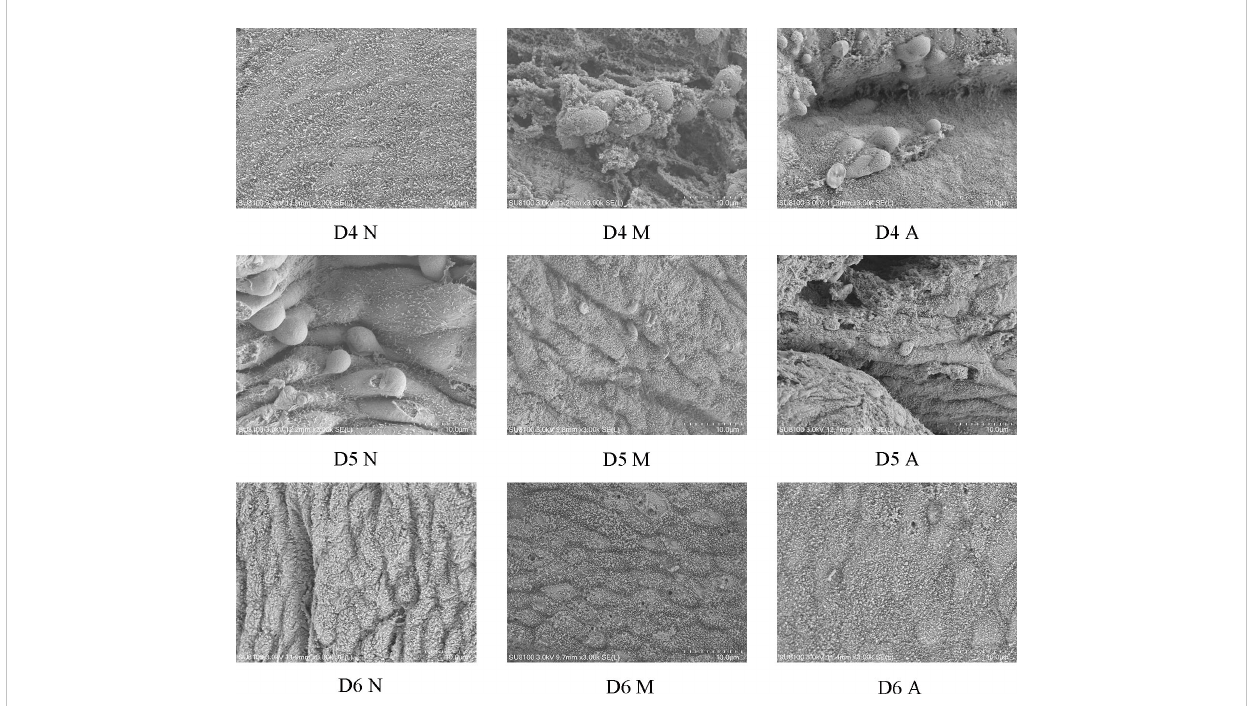
FIGURE 2 The expression of pinocytosis in endometrium of each group under scanning electron microscope (3000*). D, The embryo day; D4 N, D4 normal group; D4 M, D4 model group; D4 A, D4 acupuncture group; D5 N, D5 normal group; D5 M, D5 model group; D5 A, D5 acupuncture group; D6 N, D6 normal group; D6 M, D6 model group; D6 A, D6 acupuncture